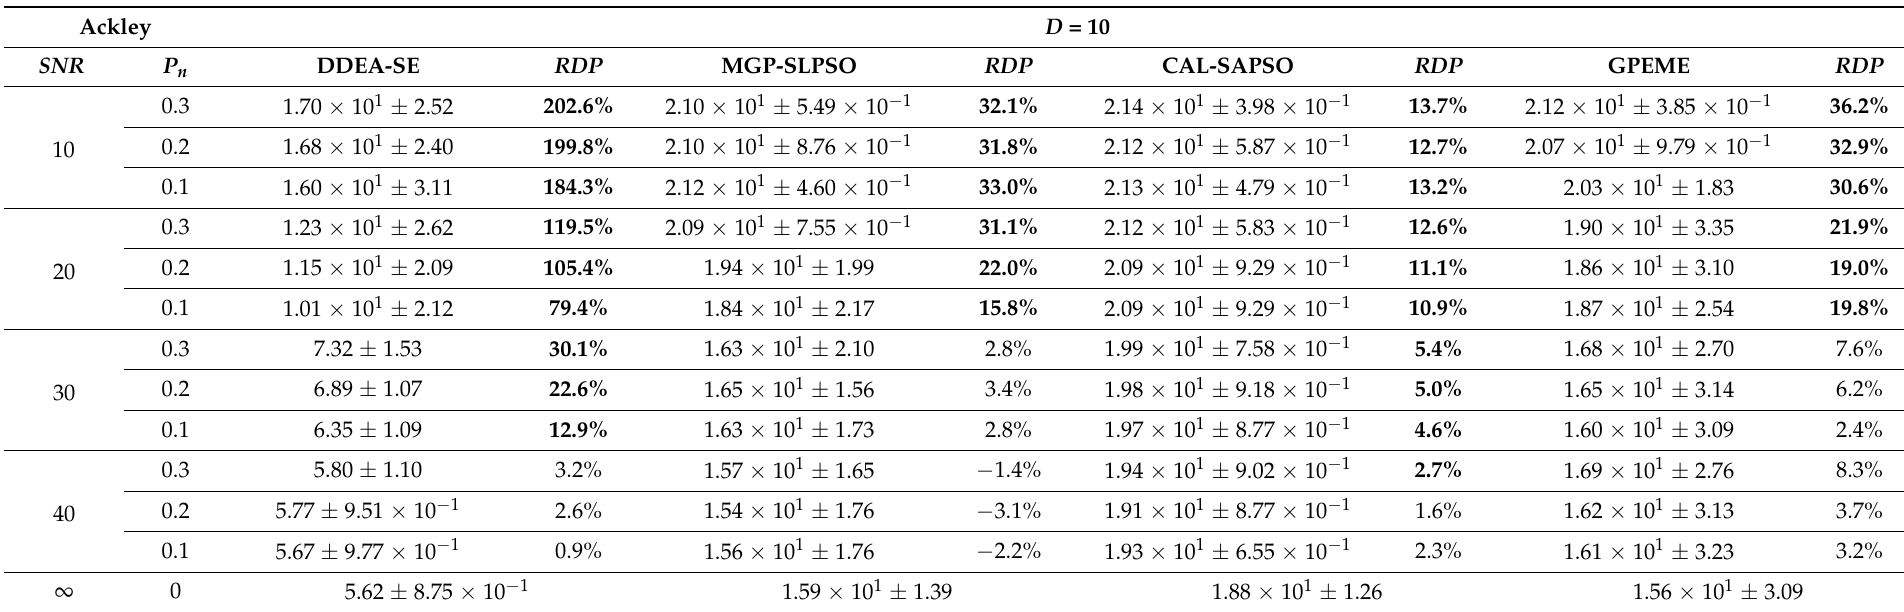
Table A5. Experimental results (with standard deviation) and RDP of DDEAs on 10-dimensional Ackley